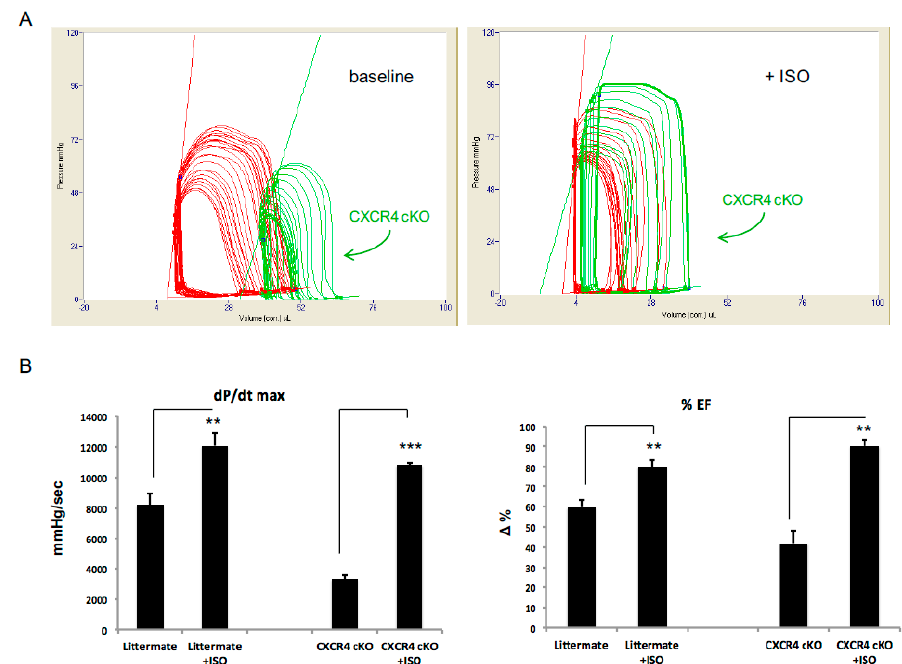
Figure 4. Effects of Isoproterenol in CXCR4 cardiac deficient mice on in vivo cardiac hemodynamics. ( A ) In vivo hemodynamic data that were acquired using a pressure-volume conductance catheter, via an open-chest approach, are shown at baseline and post ISO treatment (CXCR4 cKO-green and littermate WT-red). For this experiment we used mice at 4 months of age. We administered a 1 ng/g bolus of isoproterenol to the CXCR4 cKO, they responded in a very robust fashion overcoming their hemodynamic deficits and functioning similarly to WT controls, as shown by pressure-volume loop analysis. ( B ) Our data demonstrated that CXCR4 deficient mice had an augmented response to ISO with a greater increase in ejection fraction (EF) and dp/dt max . Importantly, since the CXCR4 cKO were operating at lower hemodynamic values, the exaggerated change in dP/dt max , and EF for experimental animals implies that CXCR4 deficiency confers additional sensitivity to isoproterenol ( n = 5–7 mice/group) (** p < 0.01, *** p < 0.001).